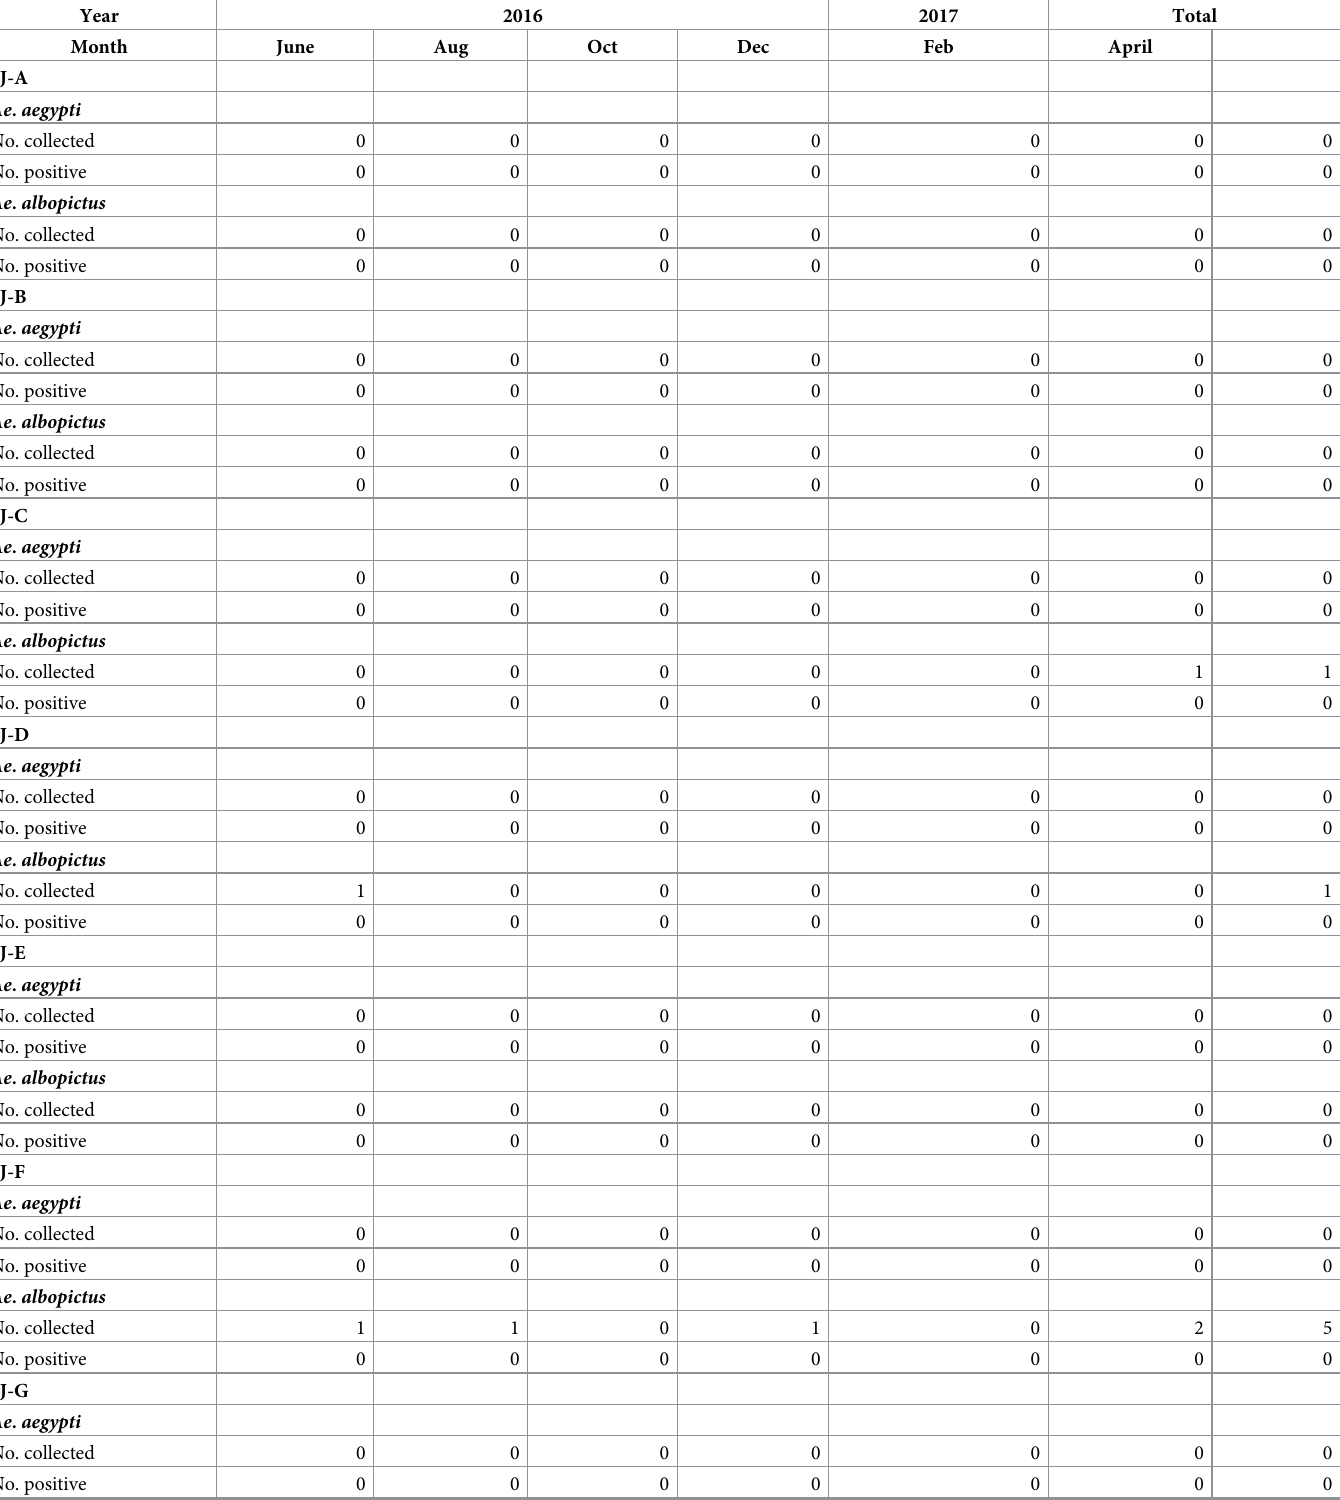
Table 4. DENV detected in adult Aedes mosquitoes collected in Selangor from June 2016 to April